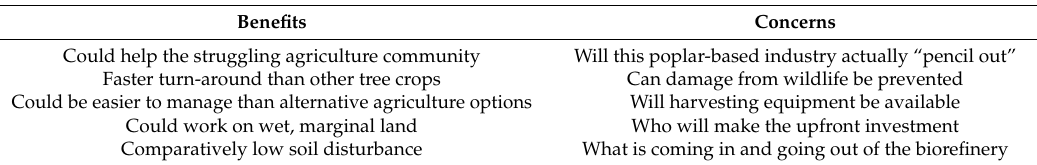
Table 2. Summary of participants’ thoughts on general benefits and concerns about the development of a poplar-based bioproducts industry in southwestern Washington,